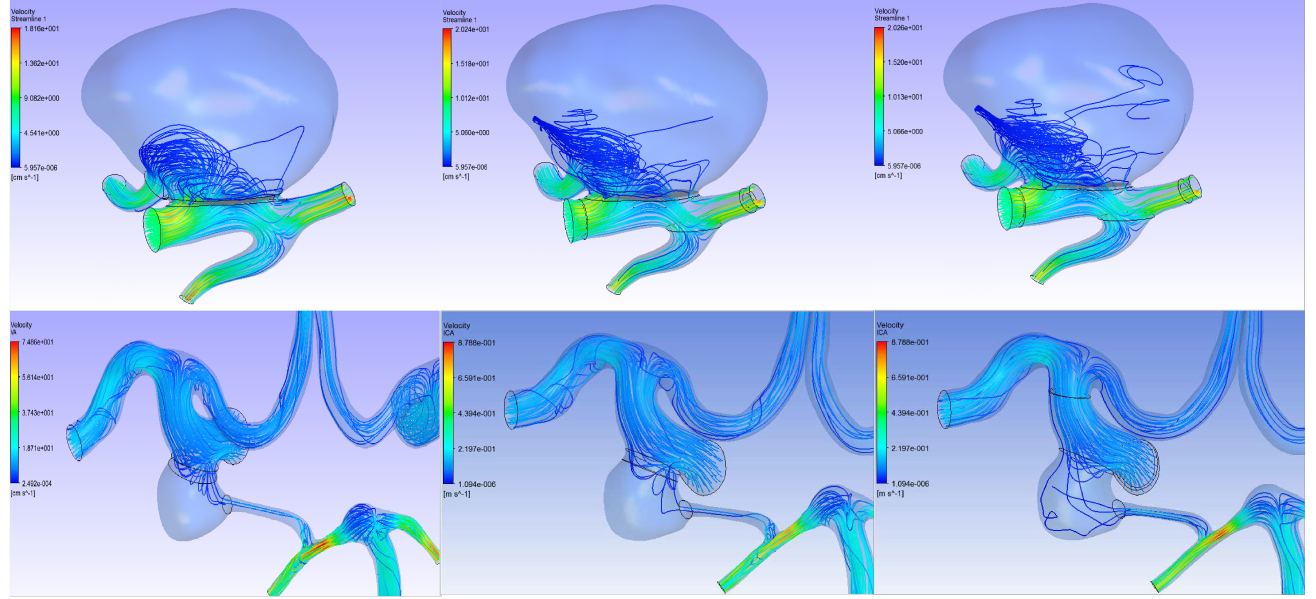
Figure 8. Velocity field streamlines for 3 scenarios of stationary numerical simulation; (on the left ) scenario A, (in the center ) scenario B, (on the right ) scenario C. Streamlines for Patients 1 and 2 are presented on the first and second lines, respectively. Table 3. Comparison of the results of hydrodynamic calculations with different scenarios for modeling a FDD. Here n 1 = 7, n 2 = 5, n 3 = 6, n 4 = 8 are the relative number of iterations of the